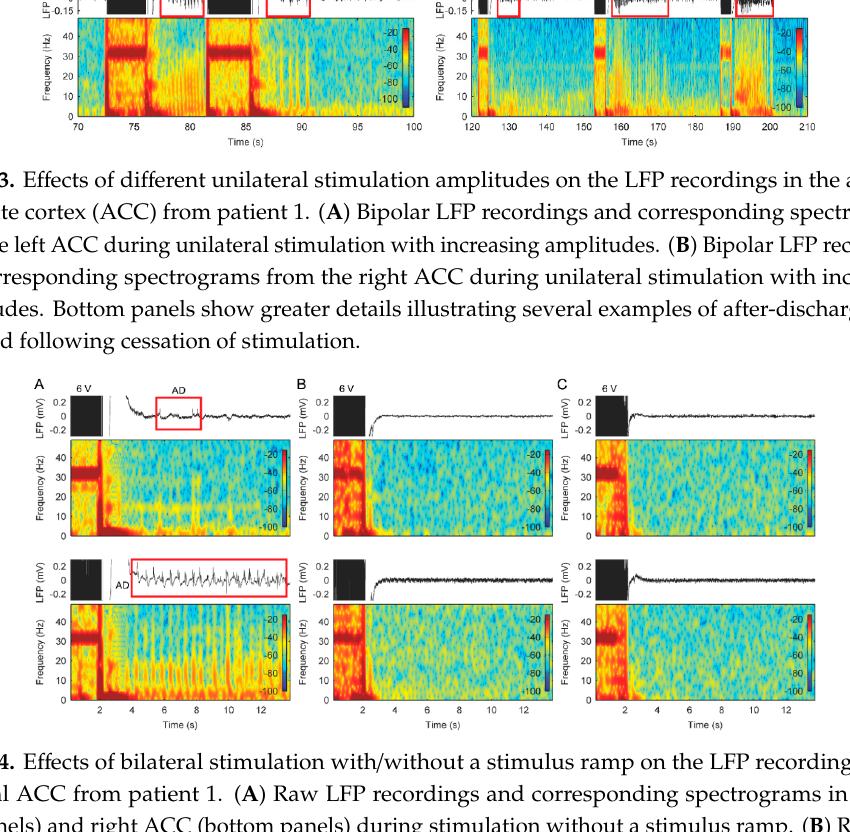
Figure 4. Effects of bilateral stimulation with/without a stimulus ramp on the LFP recordings in the bilateral ACC from patient 1. ( A ) Raw LFP recordings and corresponding spectrograms in the left (top panels) and right ACC (bottom panels) during stimulation without a stimulus ramp. ( B ) Raw LFP recordings and corresponding spectrograms in the left (top panels) and right ACC (bottom panels) during stimulation with a 4 s stimulus ramp. ( C ) Raw LFP recordings and corresponding spectrograms in the left (top panels) and right ACC (bottom panels) during stimulation with an 8 s stimulus ramp.